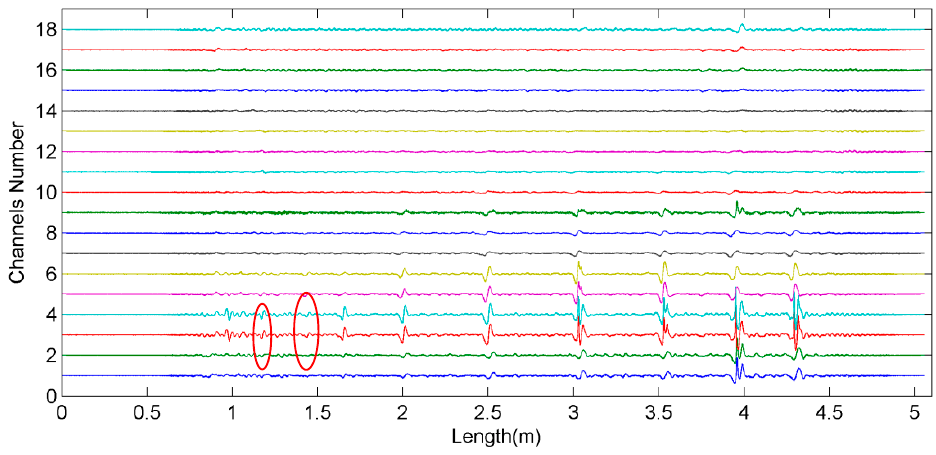
Figure 7. Expanded UME estimated signal by channel number, circles show one broken gap condition signal was circled at 1.22 and 1.46 m.